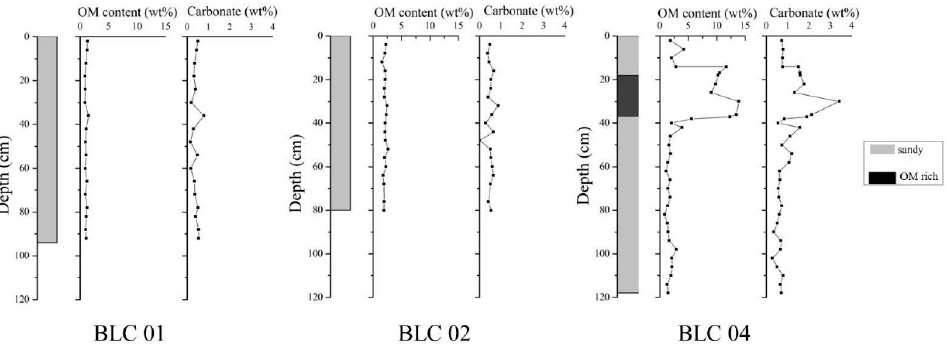
Figure 3. Stratigraphy, organic matter content (OM) and carbonate contents of sediment cores, Batticaloa lagoon.